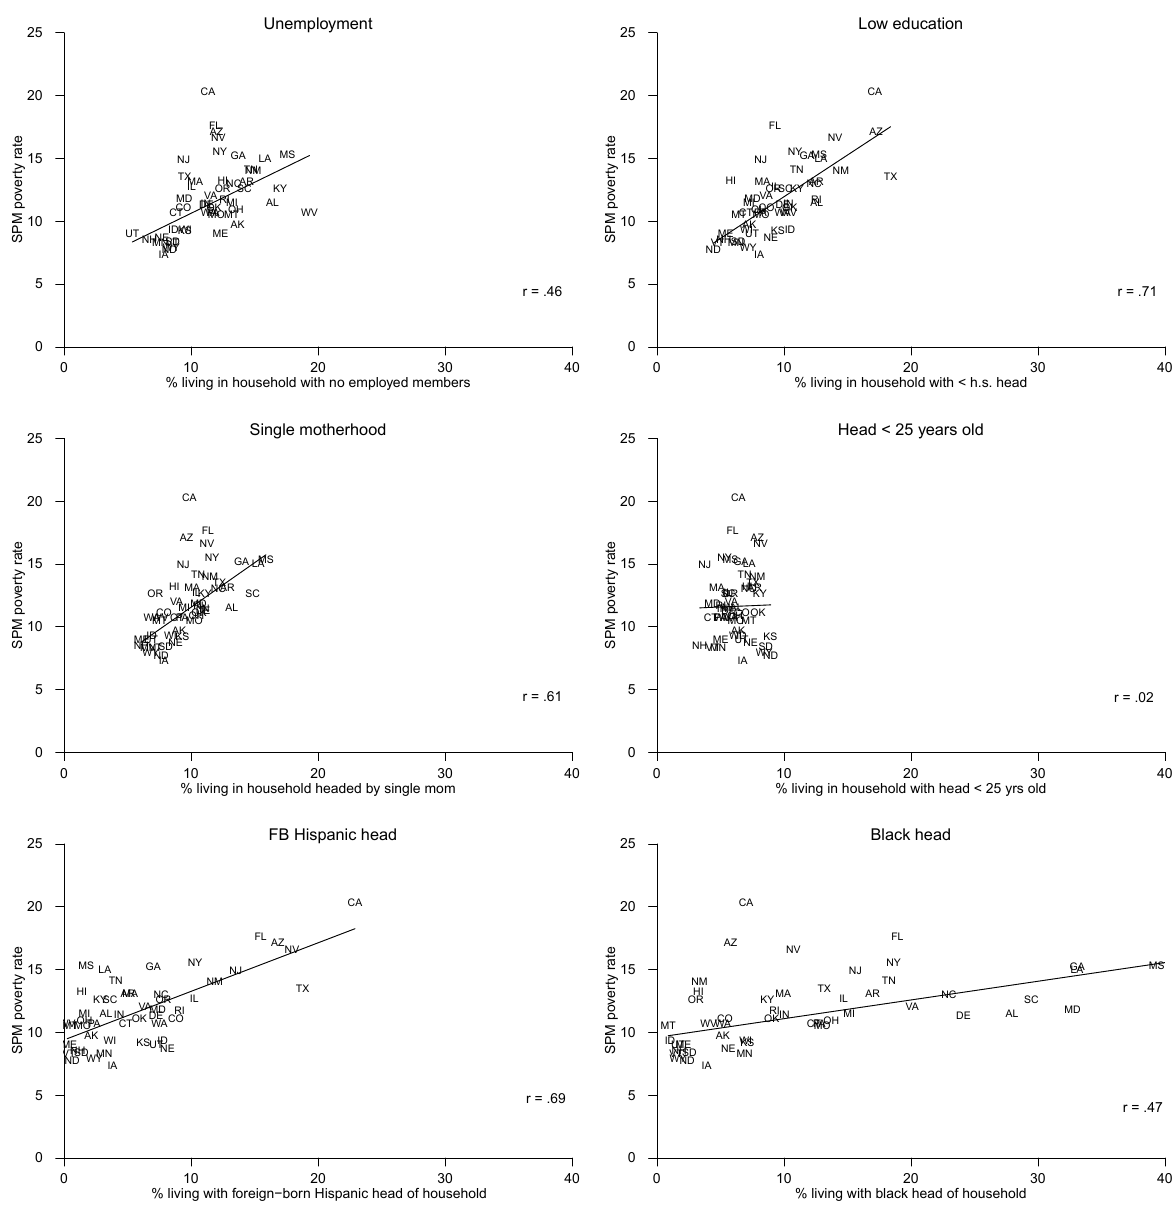
Figure 2: Bivariate relationship between risk prevalences and SPM poverty rates (2012–2016 CPS). Adjustments for SNAP, SSI, and TANF underreporting were made using the Urban Institute Transfer Income Model (TRIM). States are indicated by their postal code